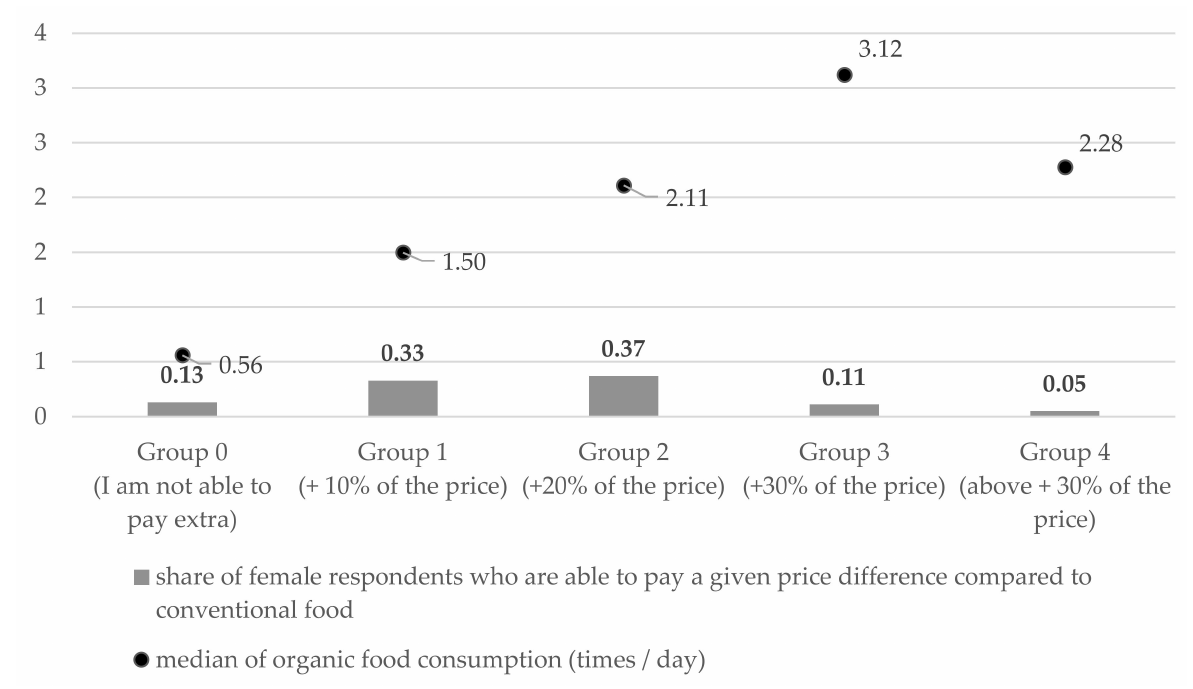
Figure 2. Willingness of the respondents to pay a higher price for certified organic food compared to the price of conventional food in relation to median consumption of organic food ( n =